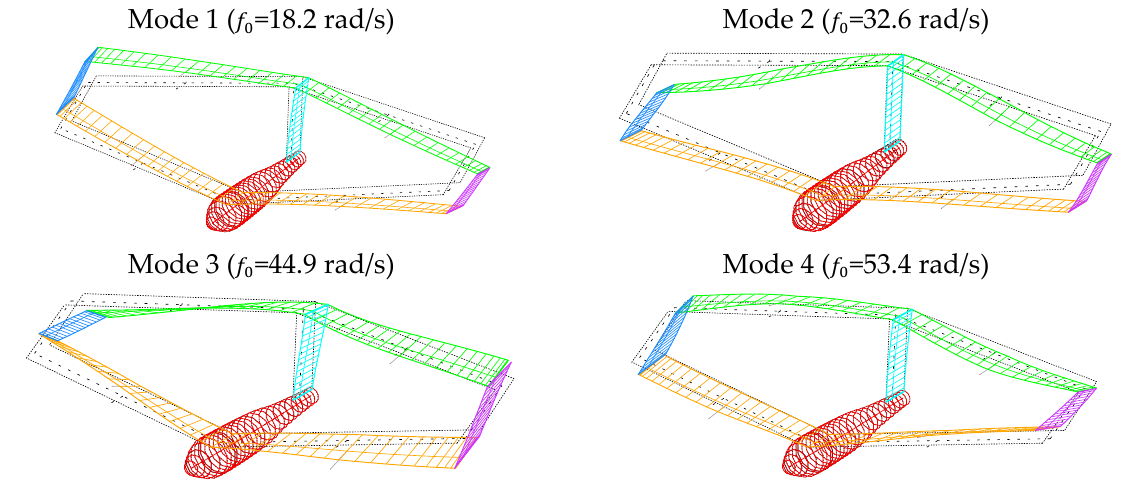
Figure 16. First natural modes and frequencies of the box-wing UAV with clamped fuselage.